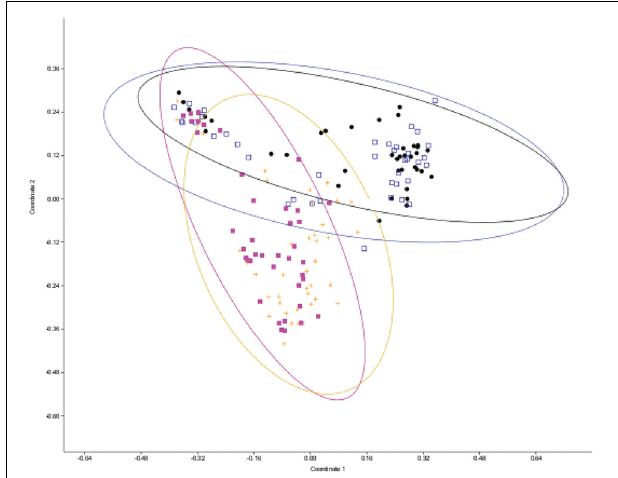
FIGURE 1 | Principal coordinates plot of leaf epiphyte microbial diversity as measured by ribosomal spacer length differences. Distance from centroid and 95% confidence ellipses are shown for each treatment level. Each point represents a microbial sample from one plant. Black squares, unfertilized, fungicide-treated plots; hollow blue squares, fertilized fungicide-treated plots; pink squares, fertilized and pathogen-inoculated plots; orange plus symbols, unfertilized and pathogen-inoculated plots.